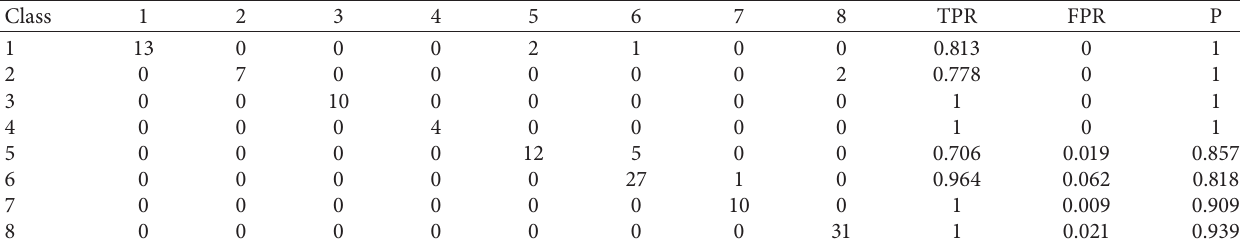
Table 14: Confusion matrix, TP rate (TPR), FP rate (FPR), and precision (P) for each